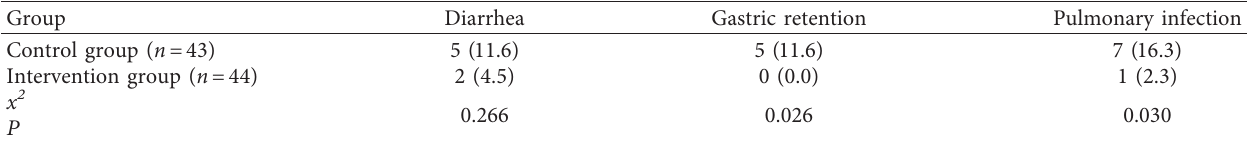
Table 6: Complications ( n